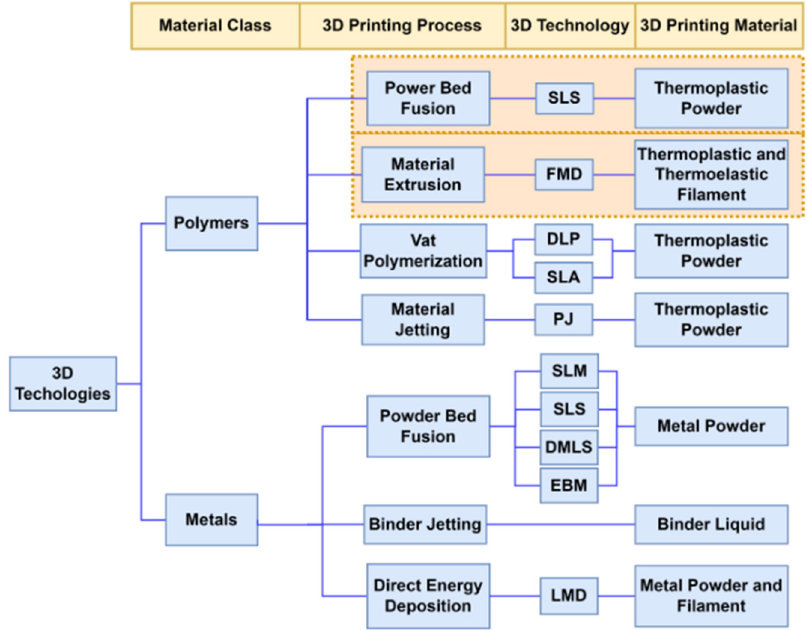
Figure 1. AM technologies classification according to ISO/ASTM 52900 [3].